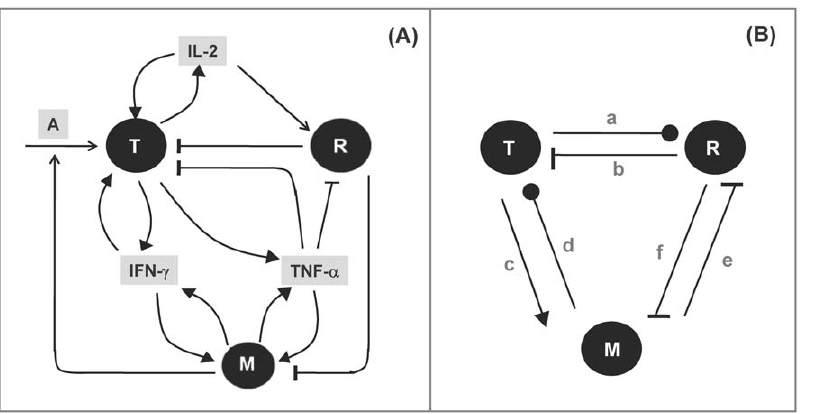
Figure 2. Modeling assumptions for Th1 responses. (A) The detailed immune network model involving Th1 activity (T), Tregs (R), and macrophages (M), with their interactions mediated by the cytokines IL-2, IFN c , and TNF a . Arrows mean ‘‘upregulate’’ or activate while hammerheads mean ‘‘downregulate’’ or inhibit. A refers to the antigen presented by M to activate T. (Fig S2 in the Appendix shows a version of the network that corresponds to the differential equations of the model.) (B) A qualitative network (qNET) summarizing the pairwise interactions between the immune cells. Arrows ending with solid black circles represent either activation or inhibition. The edges a-f are explained in the text.